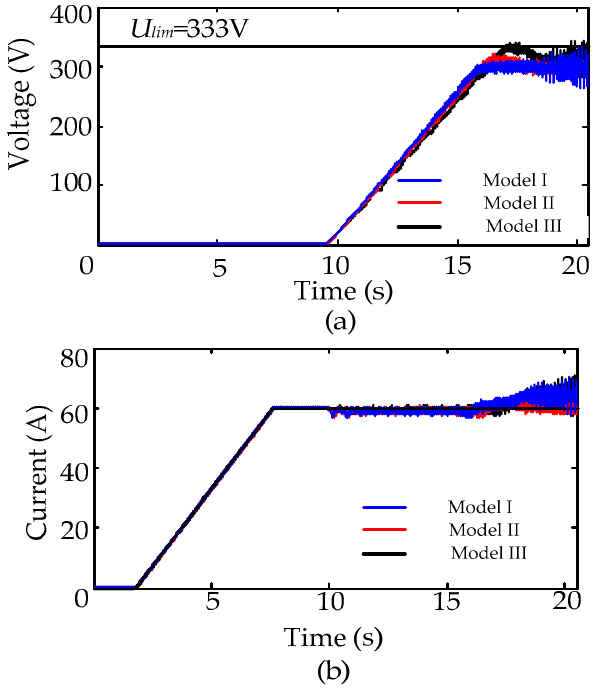
Figure 10. Simulation result of ( a ) voltage and ( b ) current amplitude when torque command is limited to 90 nm.